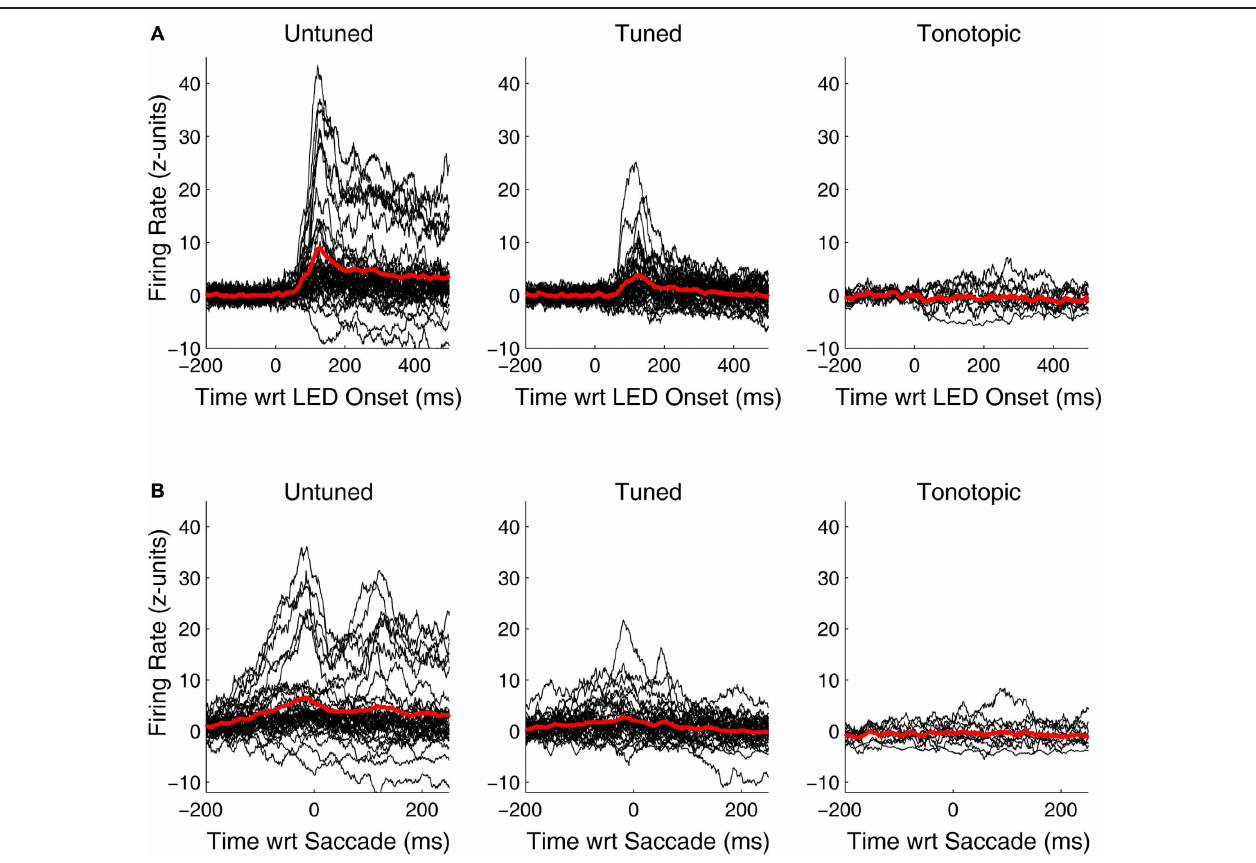
(i.e., z-scores). Averages of all significantly sensitive sites (red) are overlaid. In addition to being more common, visual responses along penetrations that showed little to no frequency tuning in the auditory domain, were generally more vigorous than others. Penetrations classified as tonotopic showed only subtle changes in firing rate following presentation of a visual